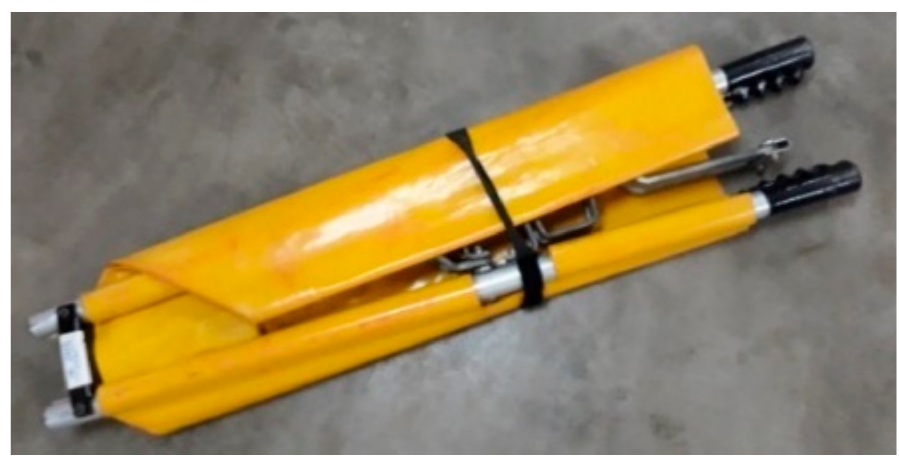
Figure 9. Completely folded normal stretcher used for test 2.